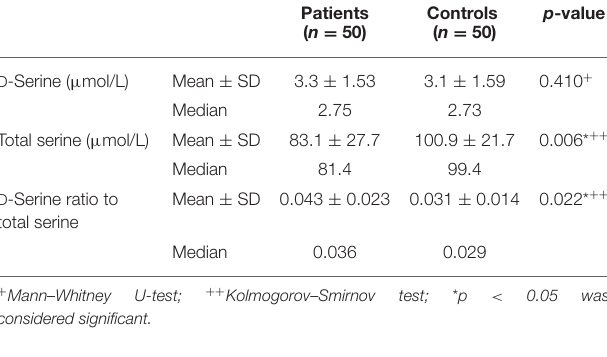
TABLE 3 | Amino acid serum levels: comparison of patients and healthy controls. Patients Controls